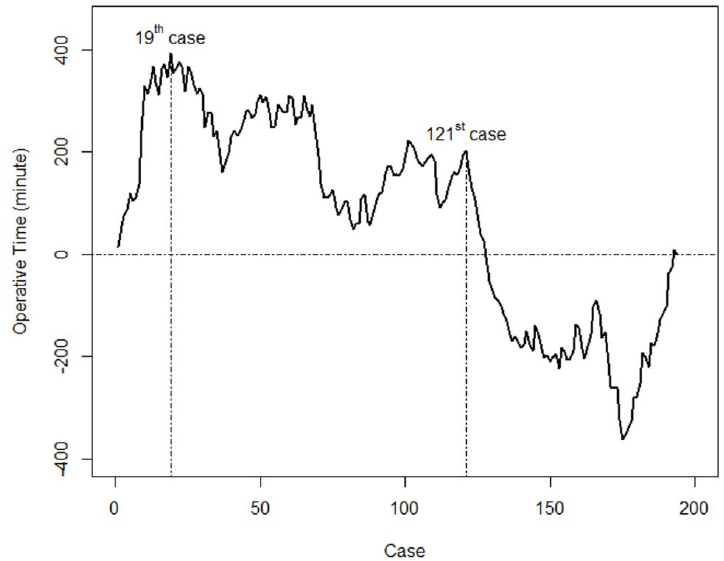
Figure 1. The learning curve for operation time as determined by the cumulative sum (CUSUM) analysis.